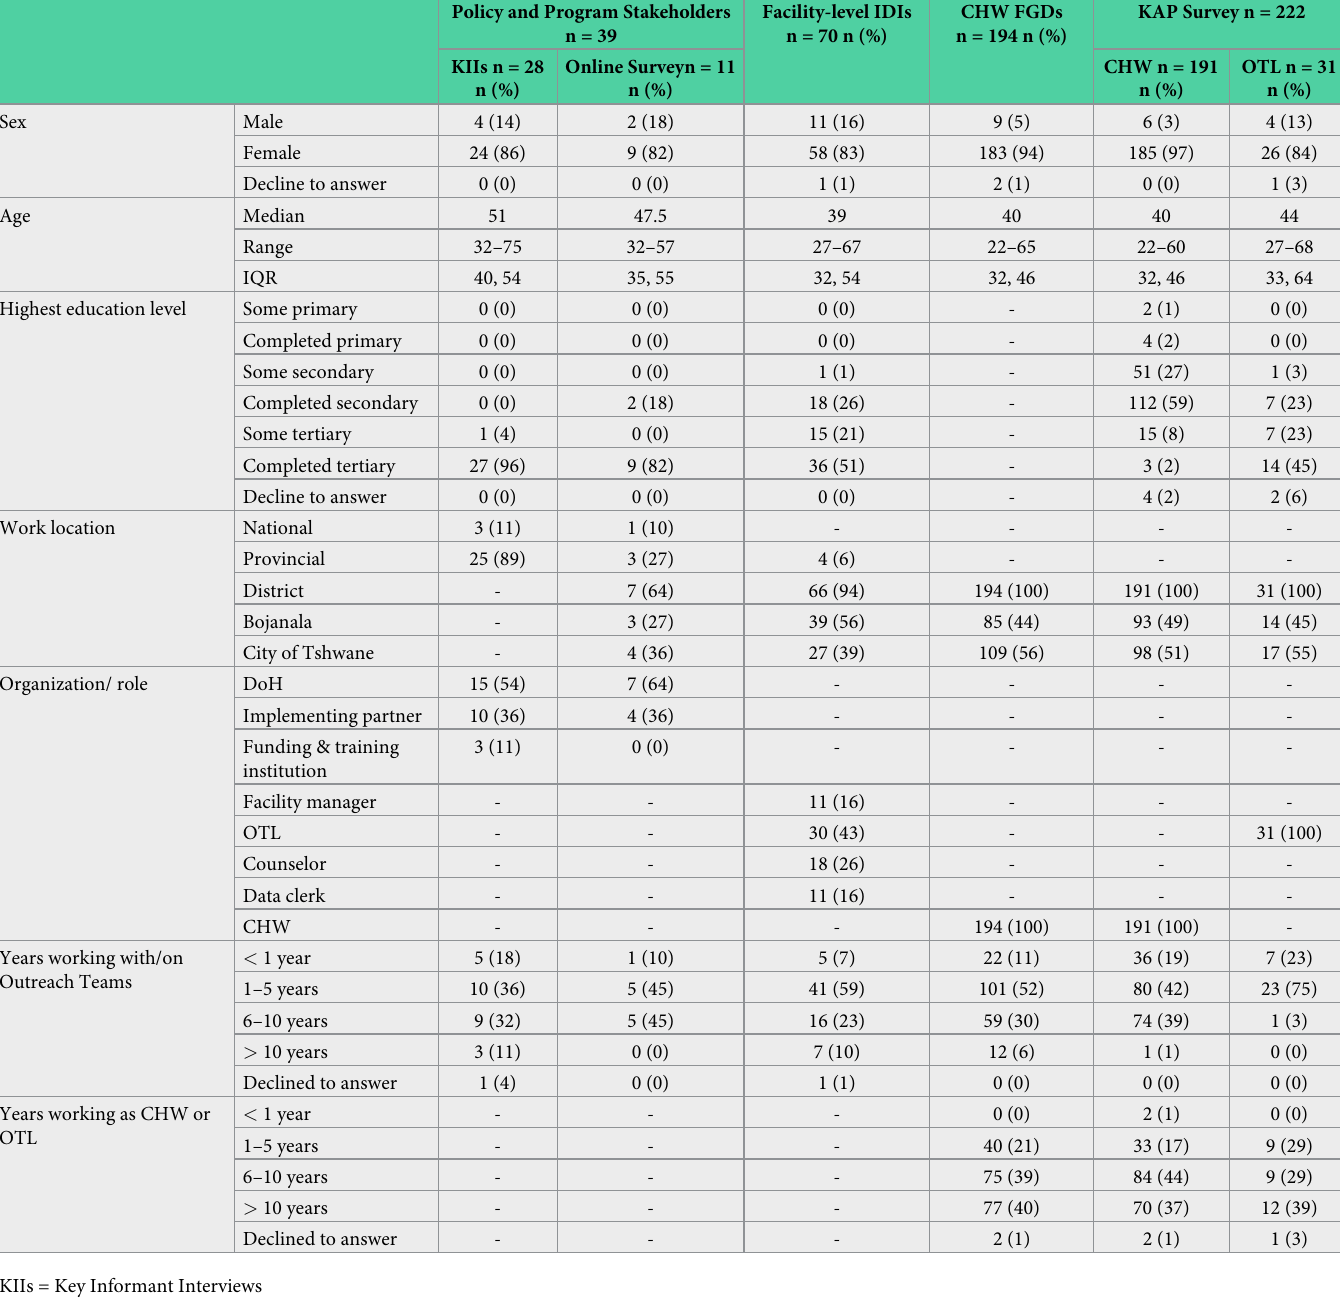
Table 3. Participant characteristics by data collection method �